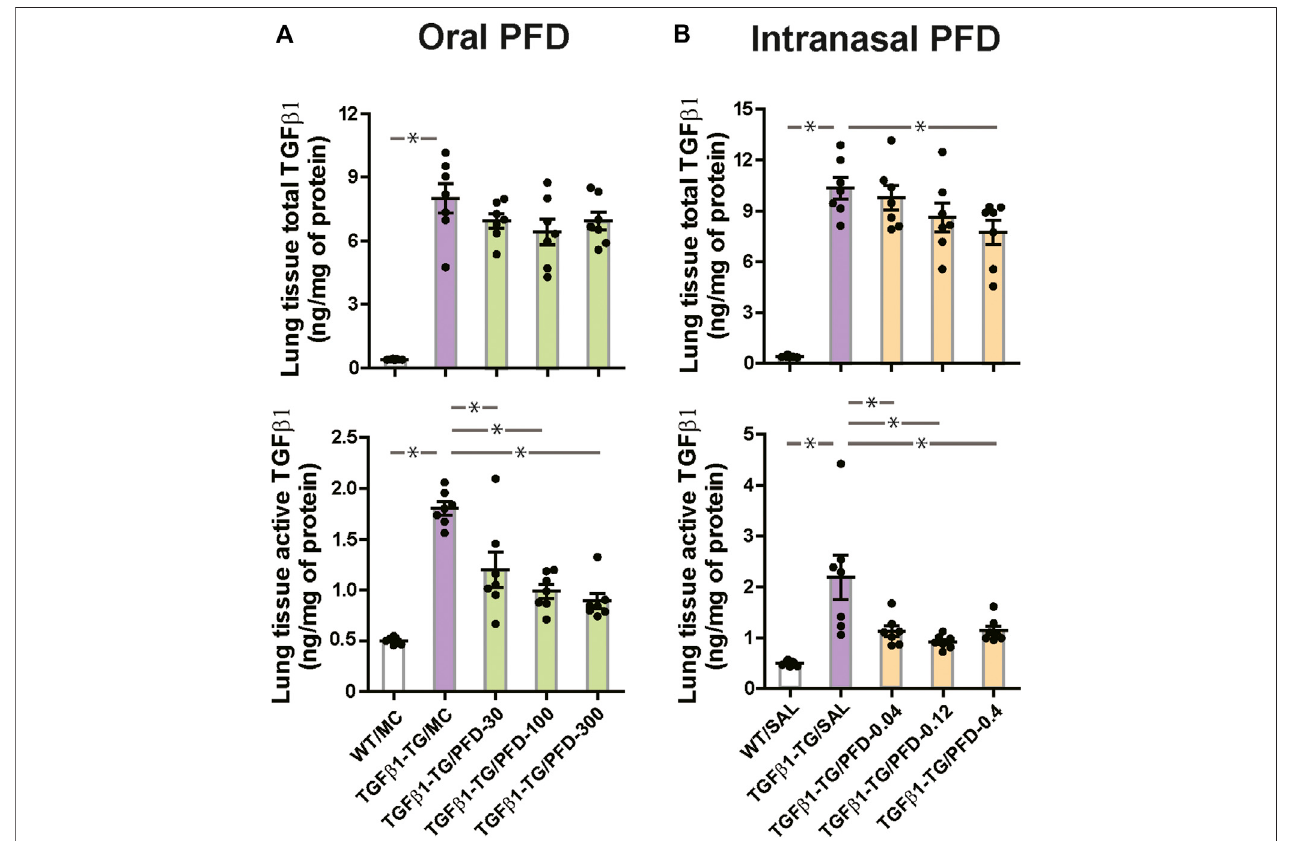
FIGURE 6 | Signi fi cant reduction in the level of transforming growth factor- β 1 (TGF β 1) in the lungs from mice treated with pirfenidone (PFD) by oral or intranasal administration compared to controls. Human transforming growth factor (TGF) β 1 transgenic (TG) mice were allocated in groups treated with PFD by oral ( A ; n (cid:2) 7) or intranasal( B ; n (cid:2) 7)administrationandingroupstreatedwiththevehiclesaline(SAL; n (cid:2) 7)orwiththevehiclemethylcellulose(MC; n (cid:2) 7)twiceadayfor21daysandonce a day on day 22before euthanasia. Wild type (WT; n (cid:2) 7) mice treated with saline or MC were used asnegativecontrols. Data are expressed as the mean ± S.E.M. Statistical analysis by Student ’ s t -test and ANOVA with Dunnett ’ s post hoc test. * p < 0.05.